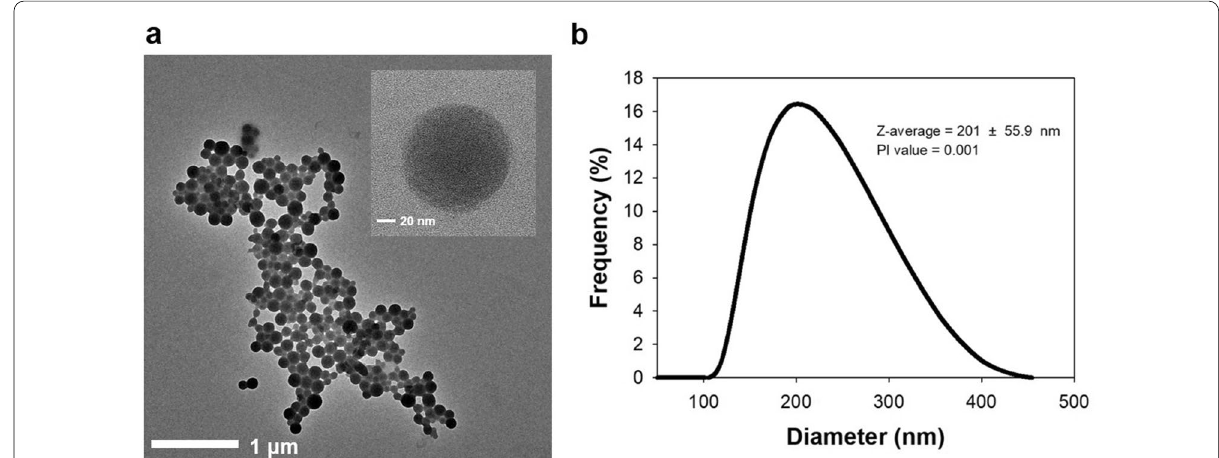
Fig. 2 Characteristics of HEPNP. a Transmission electron microscopy (TEM) image of the synthesized HEPNP at pH 8, b Dynamic light scattering (DLS) analysis of the synthesized HEPNP at pH